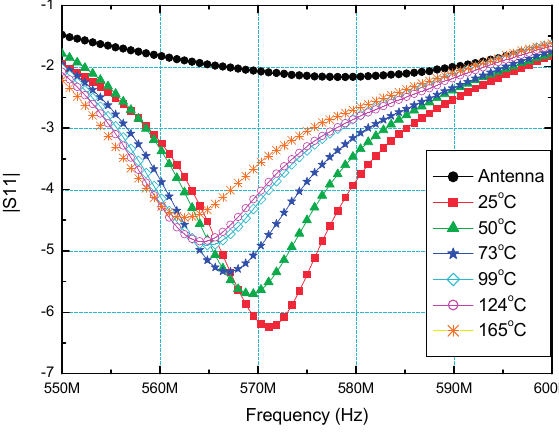
Figure 11. The parameter |S11| as a function of frequency and temperature.